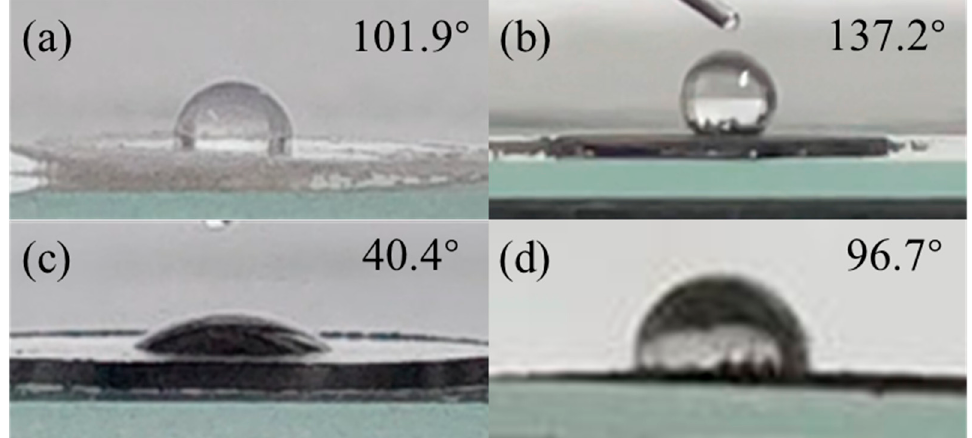
Figure 1. Measurement results of solid particle contact angle. ( a ) Hydrophobic nano-fumed silica, ( b ) coconut shell coke, ( c ) GO, ( d ) CTAB-GO.